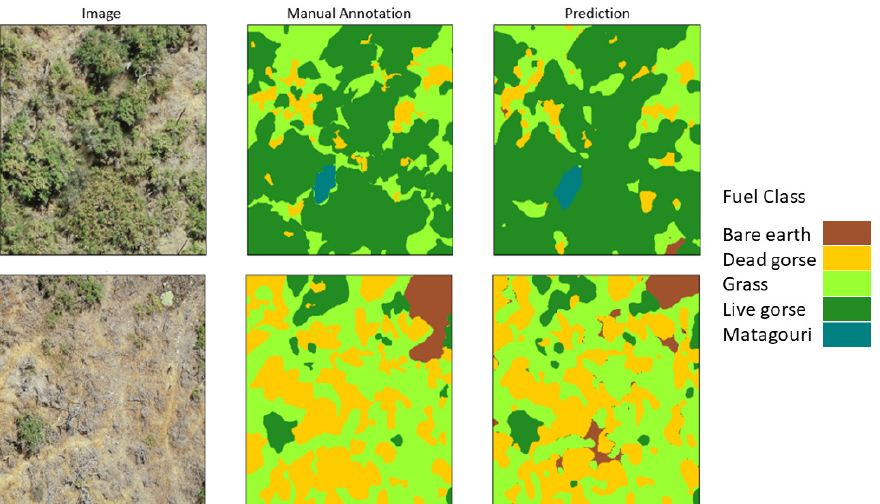
Figure 5. Manual annotations vs. model predictions for two randomly selected images from the test set.